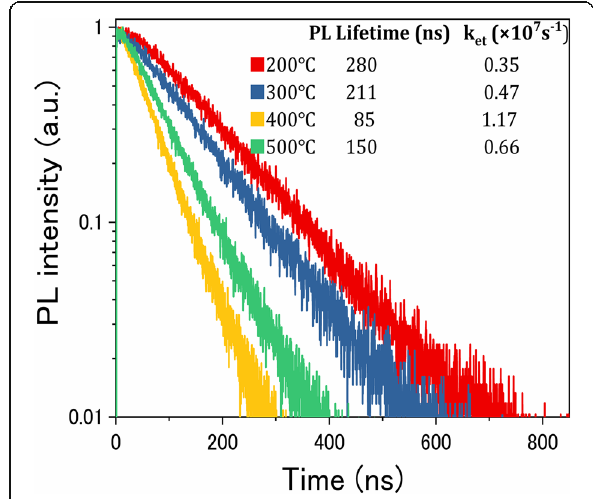
Fig. 8 TRPL spectra of CIS QD-sensitized TiO 2 films. The inset presents the PL lifetime and the rate of electron